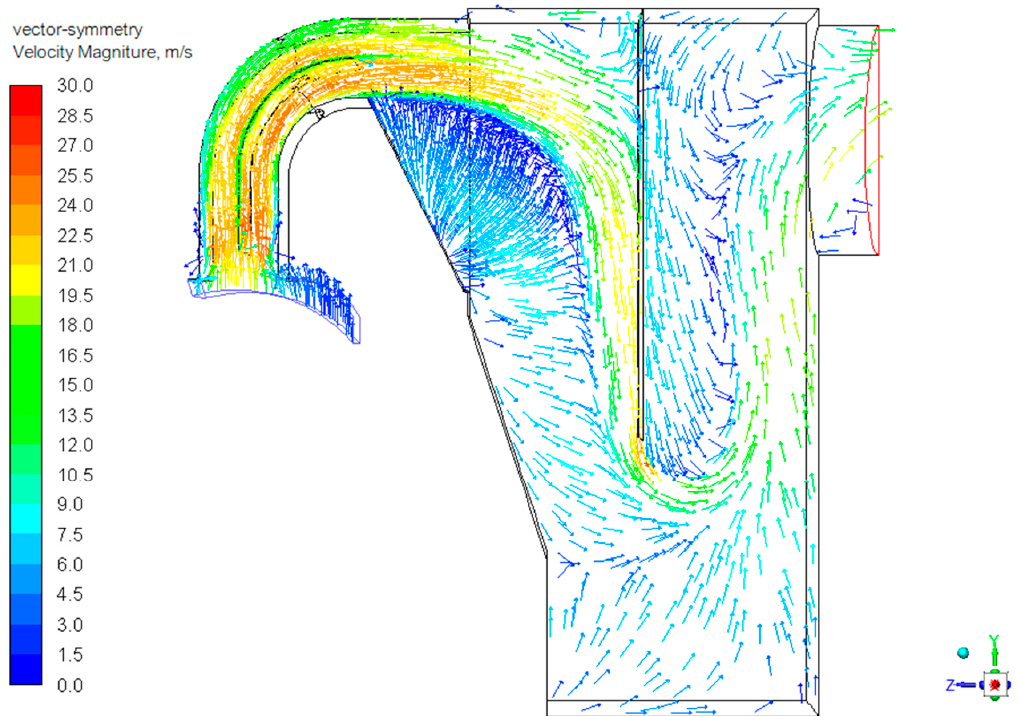
Figure 10. Vectors of air velocity in the sorter symmetry plane (simulation of the main fan at 35 Hz).